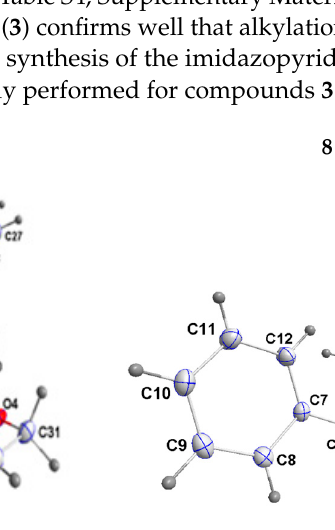
Figure 2. View ORTEP of compounds 3 , 6 and 8 [36].